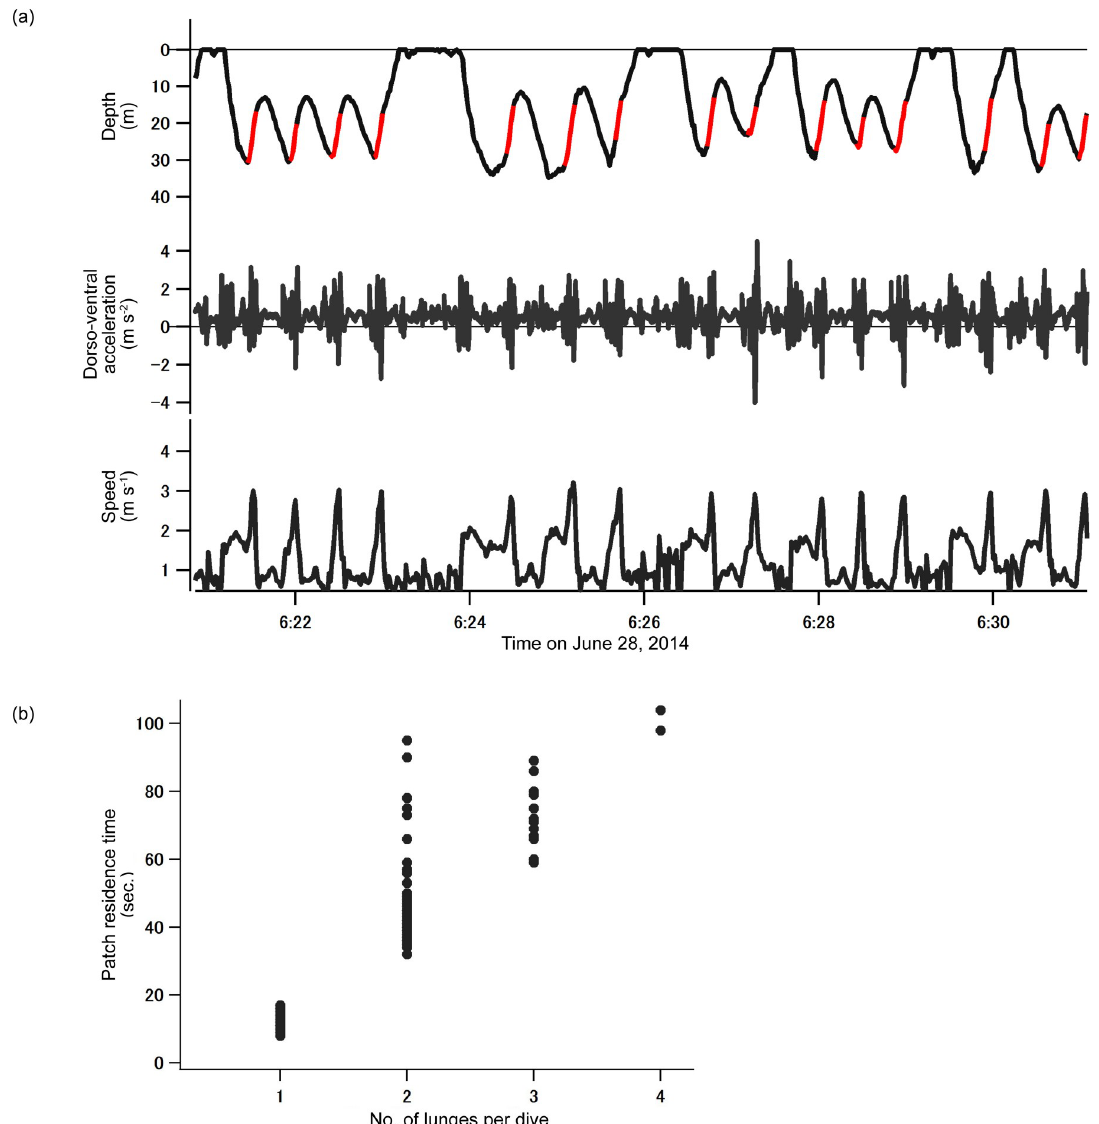
Fig 3. Characteristics of lunge dives. (a) Diving behavior of a humpback whale (ID: WhC14). Dive profile with lunge events (indicated in red), dorso-ventral acceleration, and swim speed in dives with varying numbers of lunges per dive (b) Relationship between patch residence time and number of lunges per dive, showing positive correlation (Spearman’s ρ = 0.78, P < 0.001).